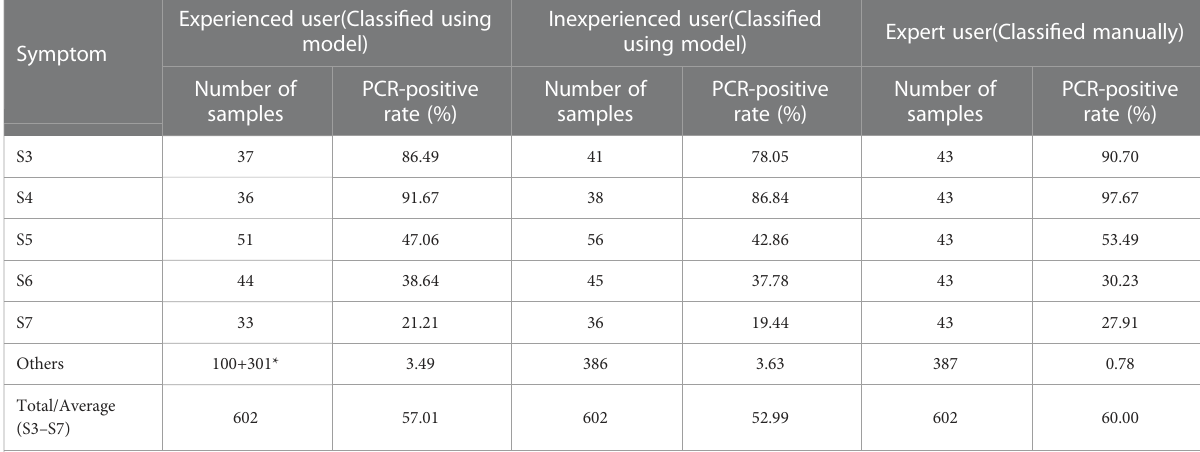
TABLE 4 PCR-positive rates of fi ve HLB symptoms classi fi ed by different users manually or using model Yolov5l-HLB2.